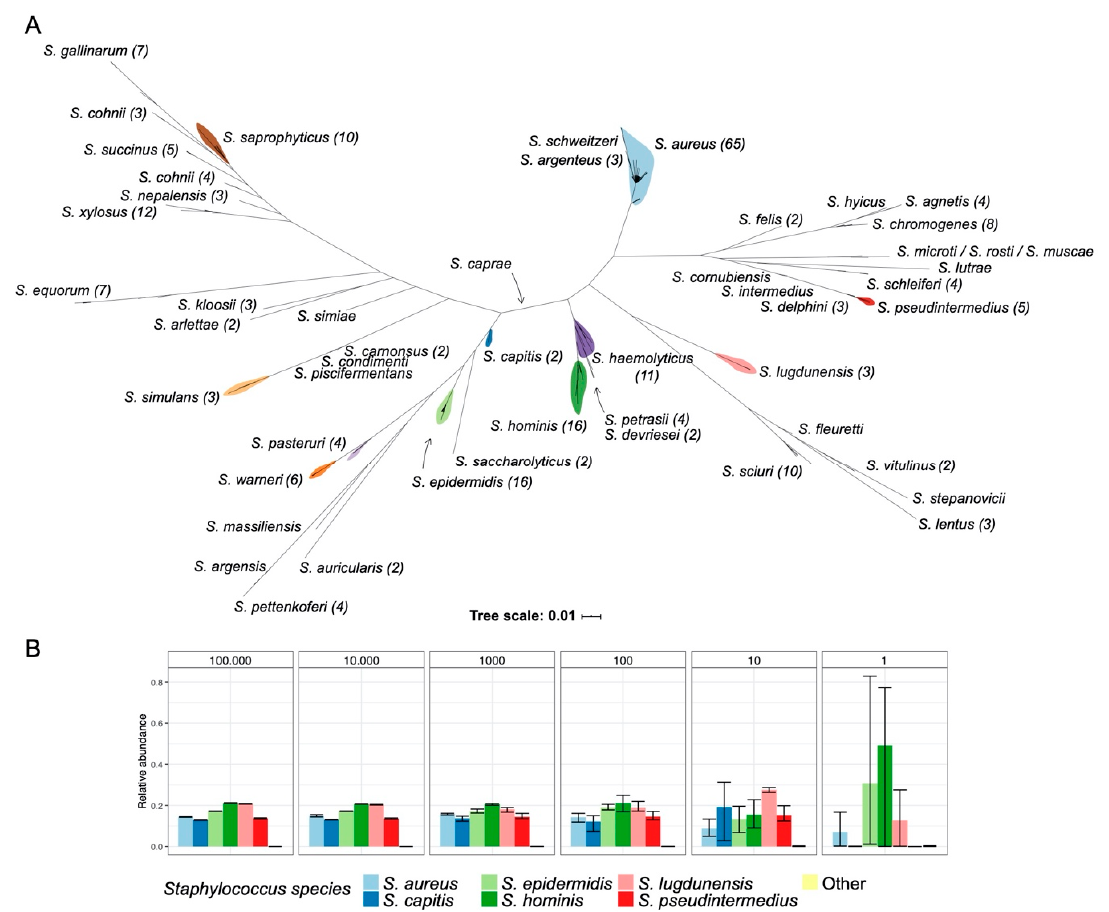
Figure 2. Phylogeny of the tuf gene region used in this study. ( A ) Phylogeny based on tuf genes from > 9000 staphylococcal genomes with tuf gene ASVs in each staphylococcal species shown in parenthesis. ( B ) Amplicon sequencing of tuf genes from a staphylococcal mock community composed of equal amounts of genomic DNA from Staphylococcus aureus, Staphylococcus capitis, Staphylococcus epidermidis, Staphylococcus hominis, Staphylococcus lugdunensis, and Staphylococcus pseudintermedius in ≈ 100,000 copies / organism (left) diluted down to ≈ 1 copy / organism (right). Error bars indicate highest and lowest observation in each technical triplicate experiment.